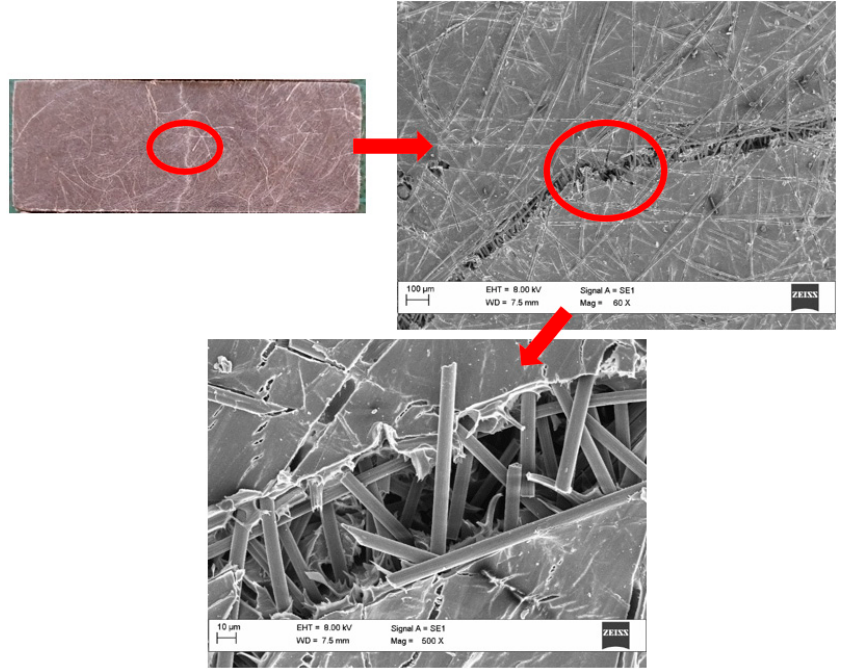
Figure 8. SEM images of the matrix crack of specimen 2-3 in 60× and 500× magnification.